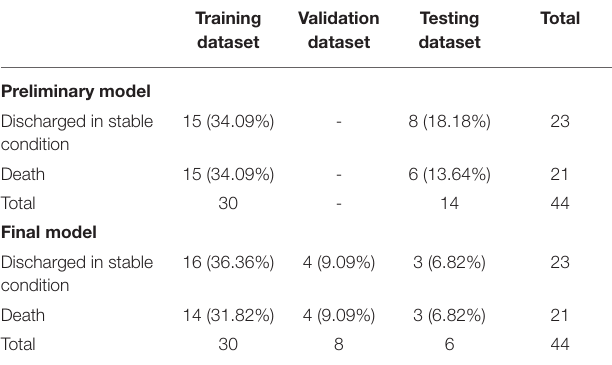
TABLE 2 | Details of the dataset for the preliminary and final LSTM